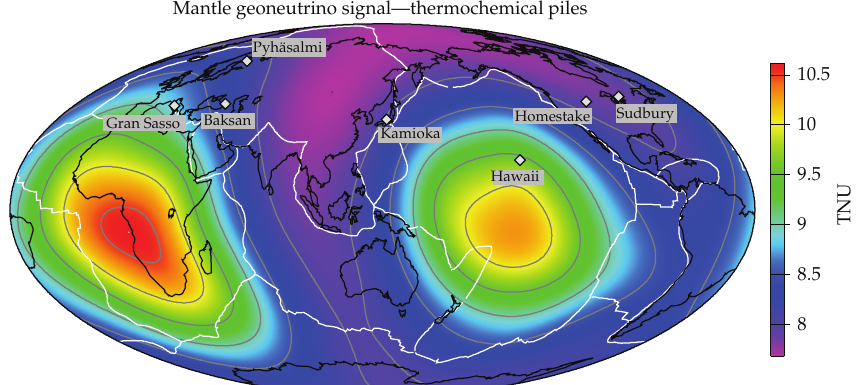
Figure 10: Lateral variation of mantle geoneutrino signal predicted for a “thermochemical piles” model. Uses BSE and DM compositional estimates of (cid:3) 60, 68 (cid:4) . See (cid:3) 69 (cid:4)